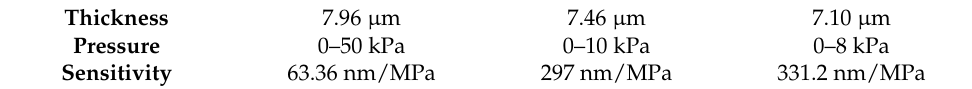
Table 1. Comparison table of pressure and sensitivity under different AB epoxy film